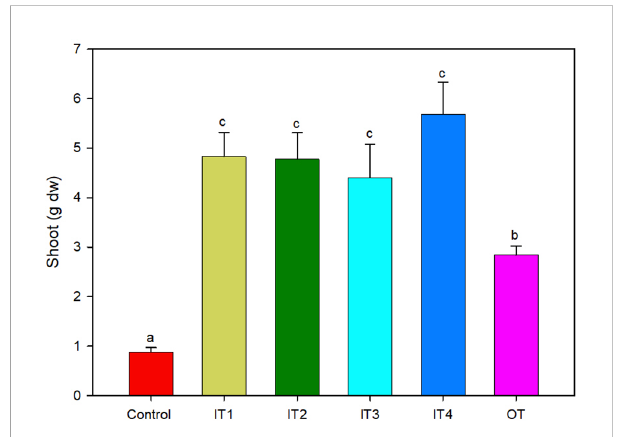
FIGURE 1 Shoot dry biomass of purslane plants grown under fi ve different fertilization treatments (n = 4). For each treatment, bars followed by the same letter are not signi fi cantly different according to Tukey ’ s HSD-test (p < 0.05). Bars represent standard